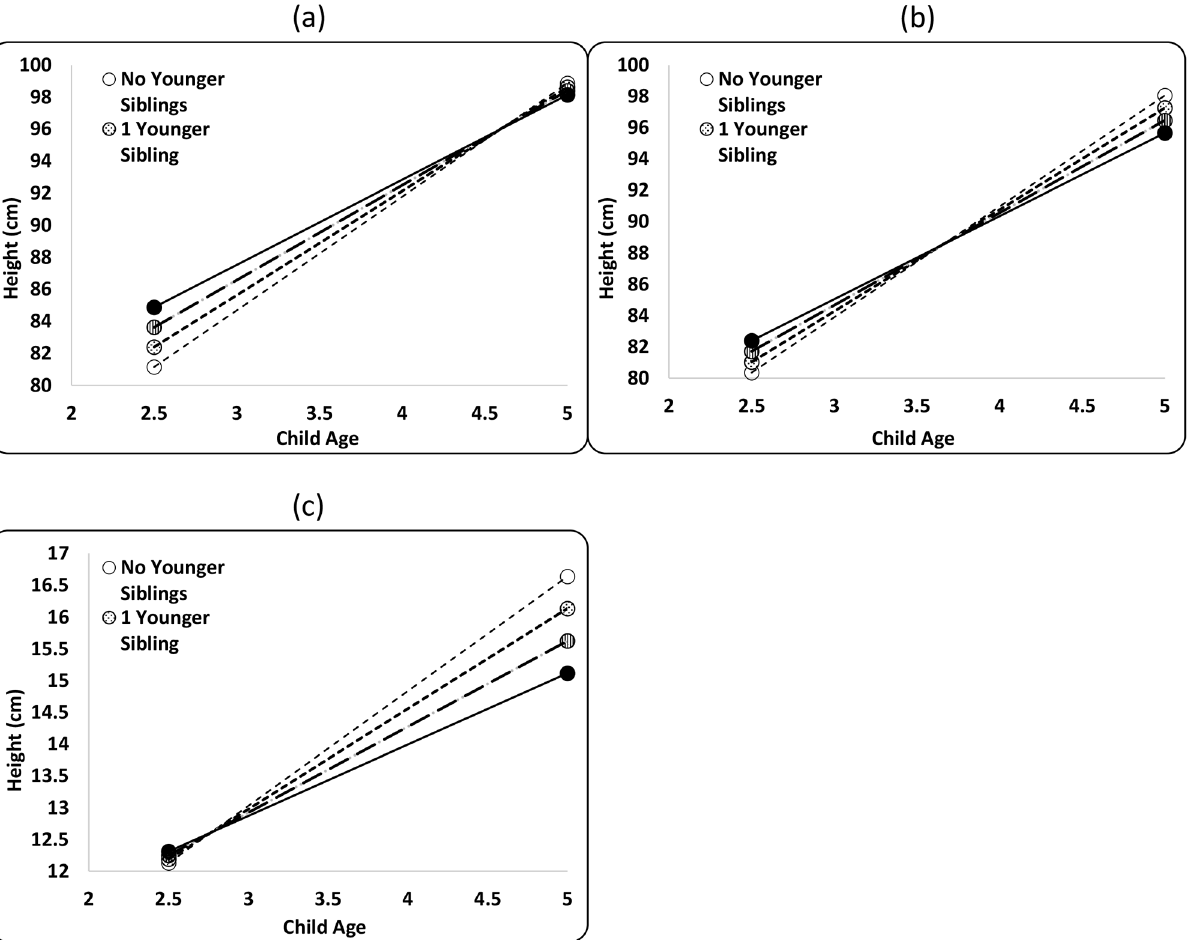
Fig 2. Growth performance stratified by the number of younger siblings (YS) for Maya children ages 2.5 – 5.0. Lines plot predicted height (cm) in (A) boys and (B) girls and predicted weight (kg) for (C) girls and boyswith 0, 1, 2, and 3 younger siblings (drawn from S1 Table Models 2a-d).